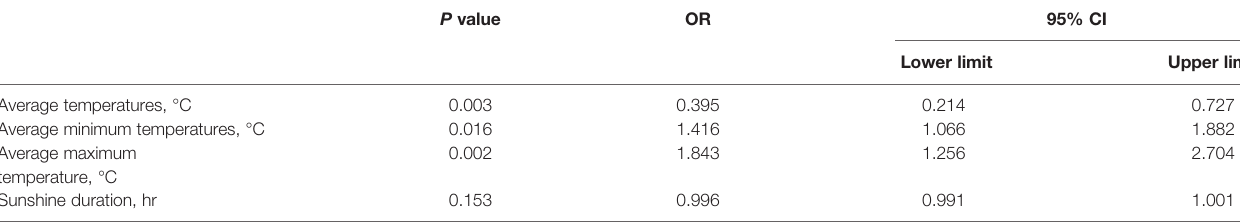
TABLE 2 | Association of high risk of ovarian hyperstimulation syndrome (OHSS) with meteorological